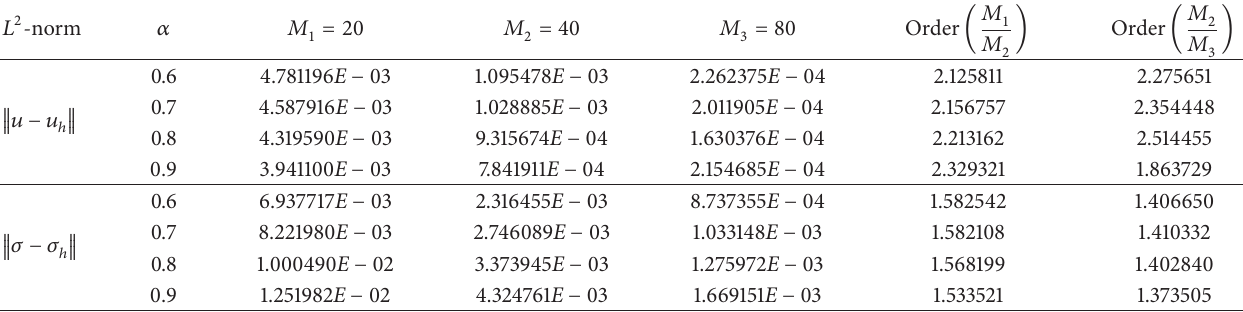
Table 3: Space-time convergence results in 𝐿 2 -norm with ℎ = 5Δ𝑡 = 1/𝑀 and changed 𝛼 .